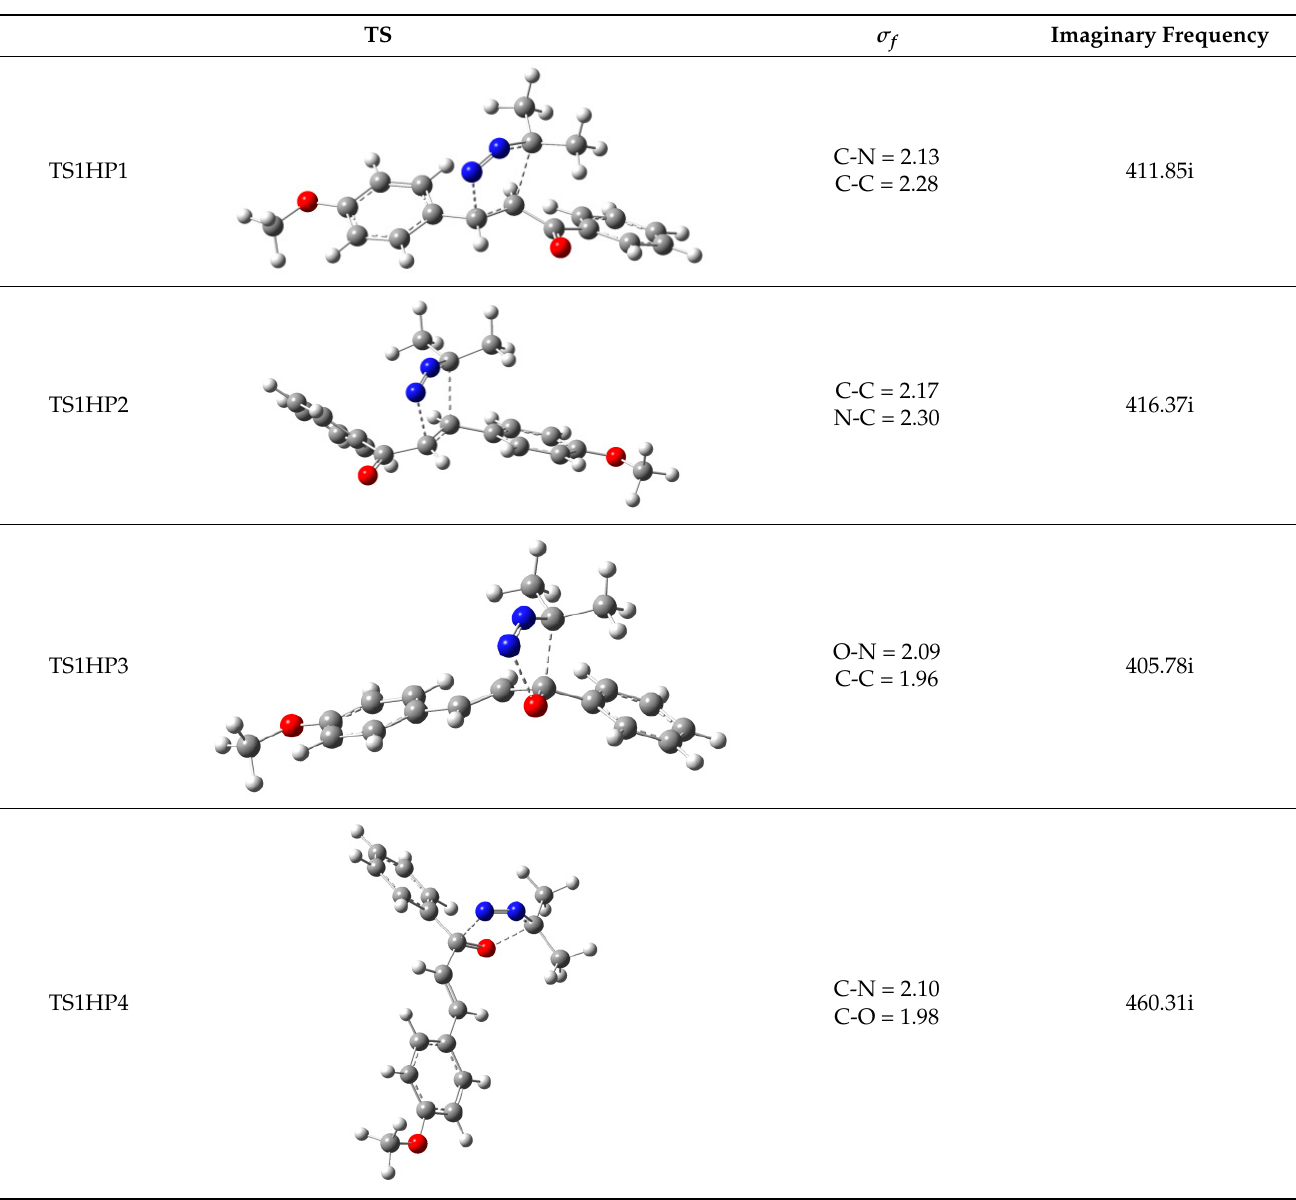
Table 3. Activation energy 𝐸 (cid:3028) (kcal/mol) and free energy change of reaction Δ𝐸 (cid:3045) (kcal/mol) values of different IRC pathways.